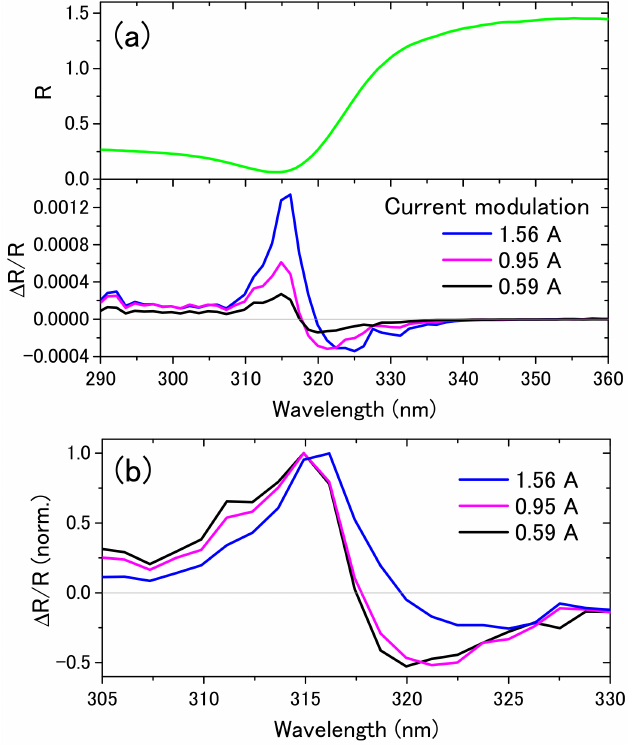
Figure 6. Change in ( a ) the current modulation spectra and ( b ) the normalized current modulation spectra with the increase in the current.